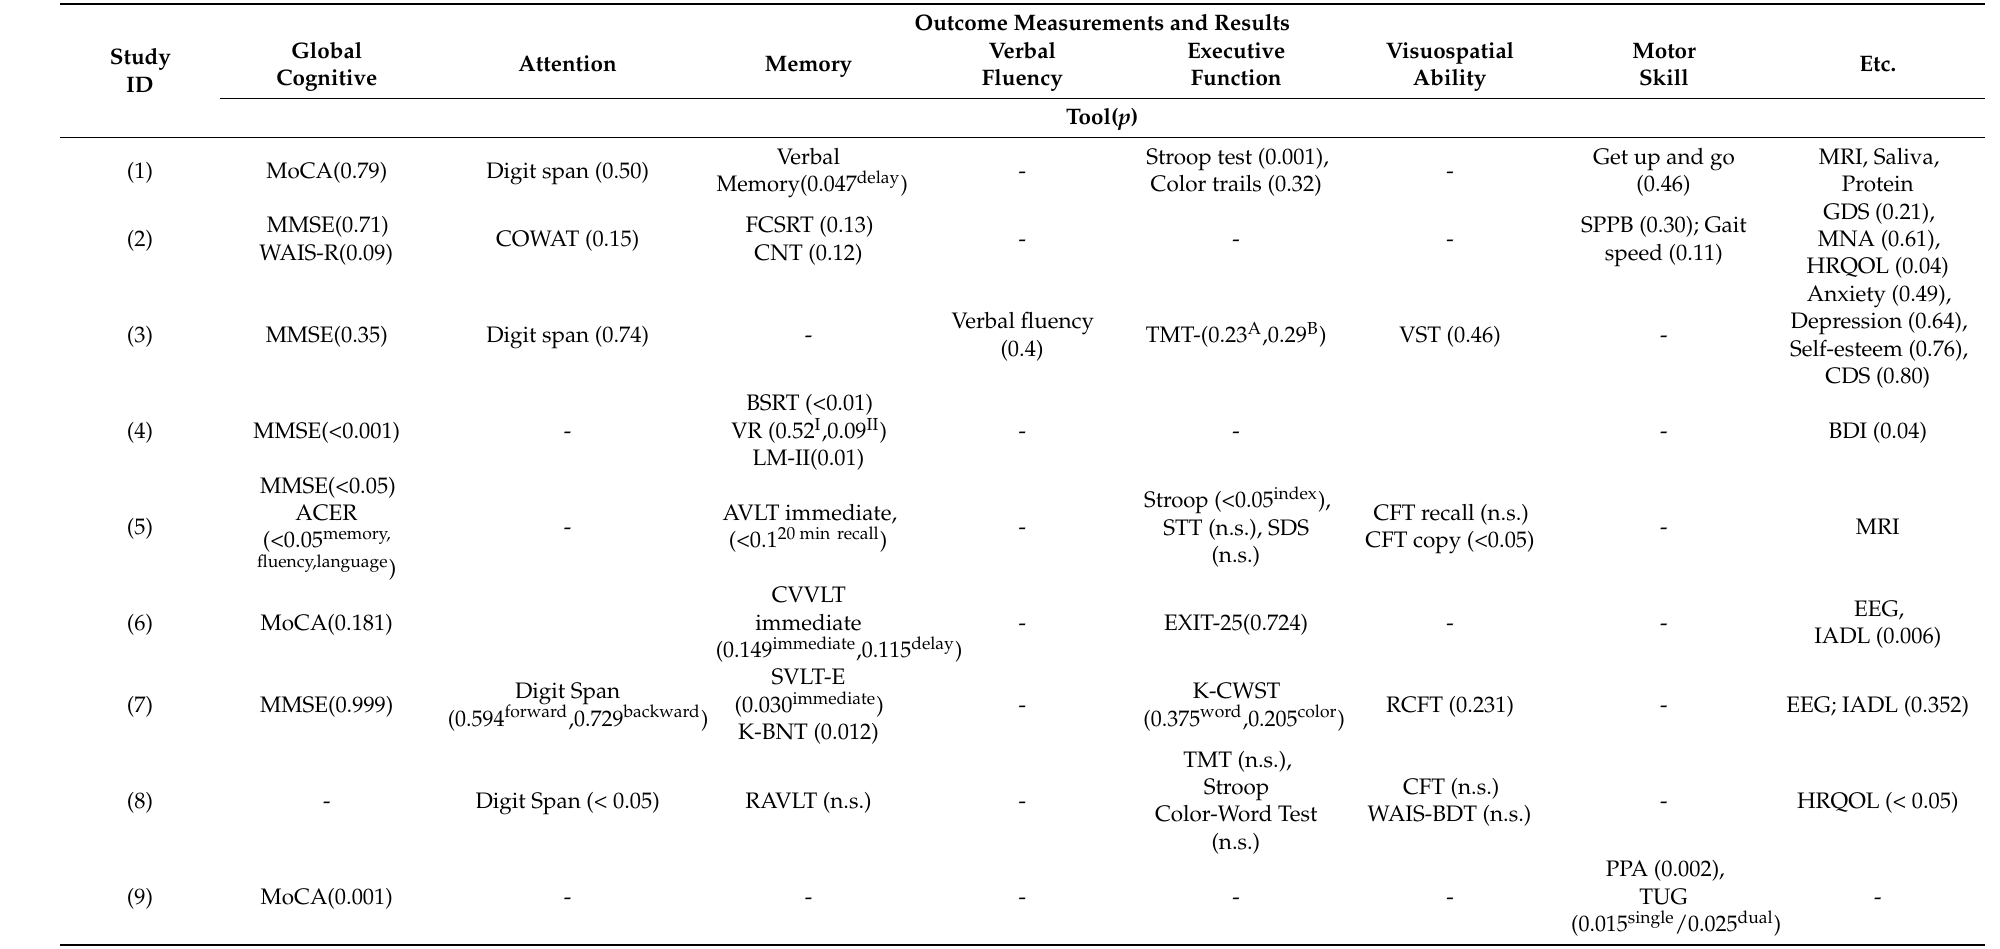
Table 5. Outcome measurements and